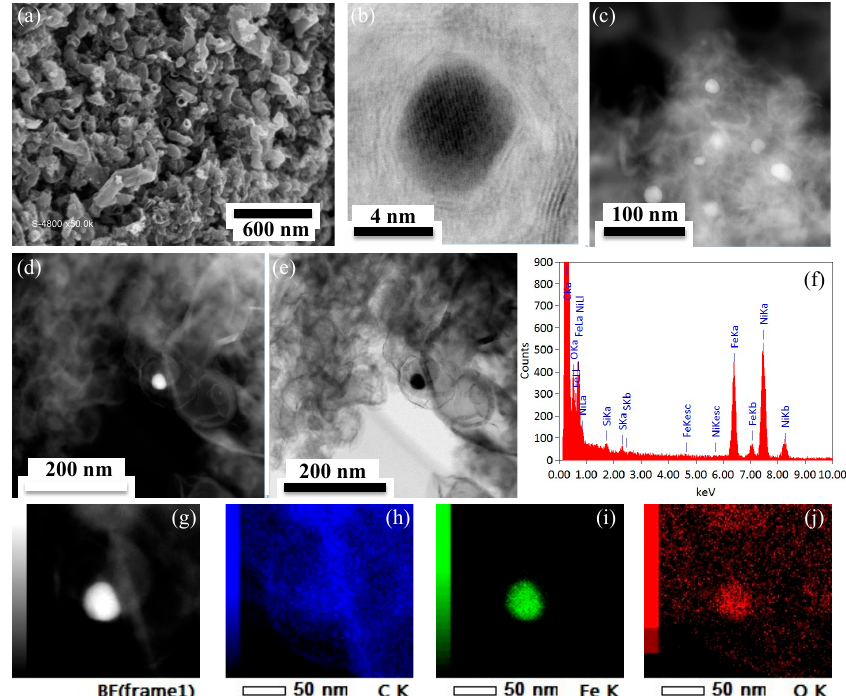
Figure 6. ( a ) Scanning electron microscopy (SEM) image of ICM-FePhen 3 -AW; ( b , e ) bright-field scanning transmission electron microscopy (BF-STEM) and ( c , d ) high-angle annular dark-field (HAADF)-STEM images, ( f ) energy dispersive X-ray spectroscopy (EDX) spectrum measured in the same area as ( d ) and ( e ), and ( g – j ) the corresponding elemental mapping.